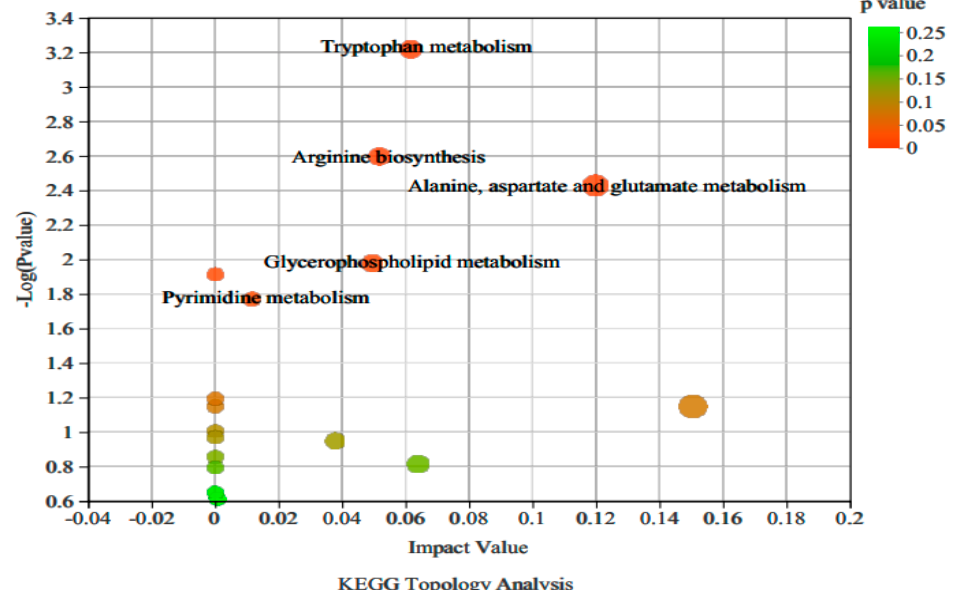
Figure 7. Bubble Chart of Z-2-GS-2 vs. GS group path topology analysis. Note: Each bubble in the figure represents a KEGG pathway; the horizontal axis represents the relative importance of the metabolites in the pathway, the impact value; the vertical axis represents the enrichment significance of metabolites involved in the pathway-log10 ( p-value ), and the size of the bubble represents the impact value. Table 3. Pathway enrichment identification results of Z-2-GS-2-VS-GS group.